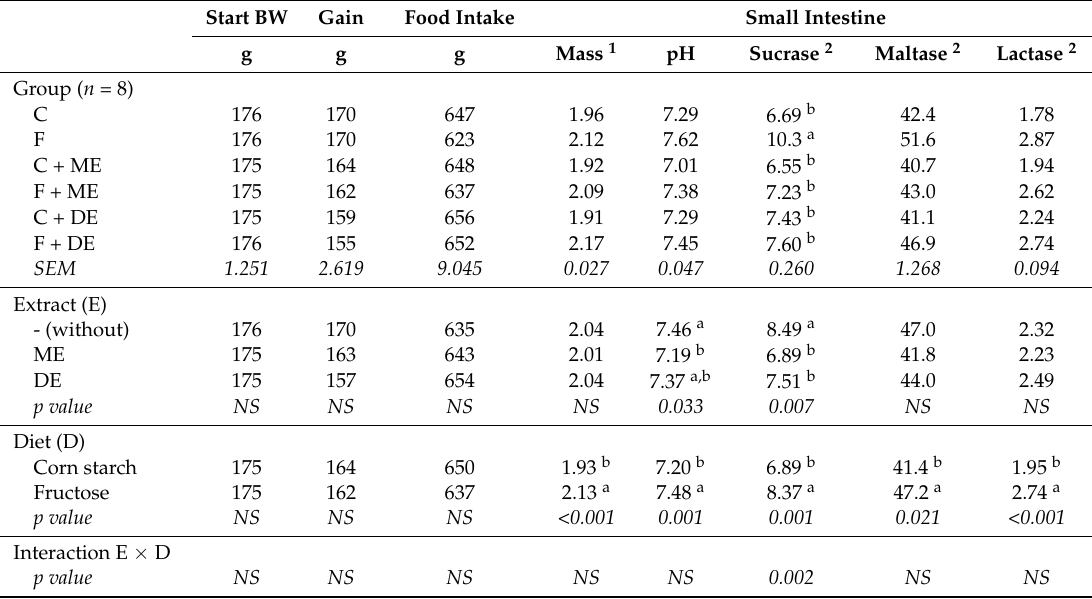
Table 2. Growth parameters and small intestinal indices of rats fed experimental diets *. Start BW Gain Food